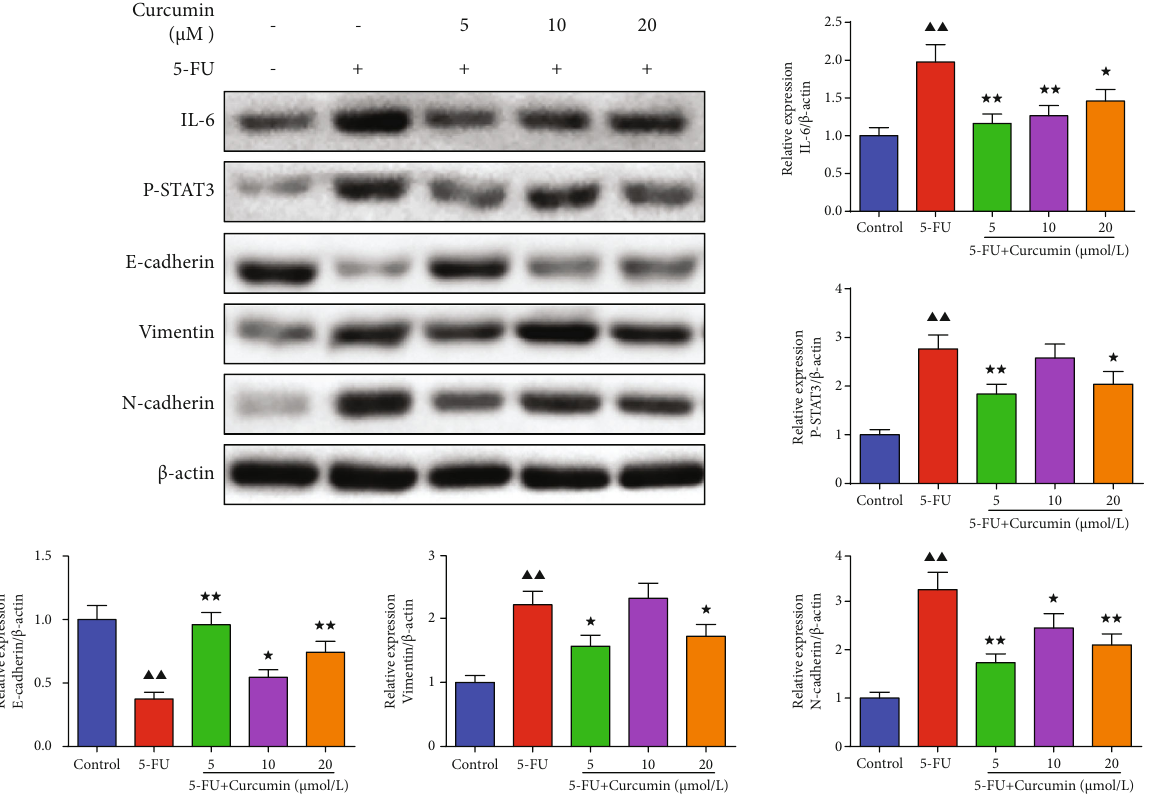
Figure 4: E ff ect of curcumin on the IL-6/STAT3 signaling in the 5-FU-stimulated IEC-6 cells. Western blotting assay was performed to detect the protein expression levels of E-cadherin, vimentin, N-cadherin, IL-6, and p-STAT3 in each group cells. Data were expressed as mean ± standard errormean (SEM), ▲▲ p value < 0.01 vs. control group; ∗ p value < 0.05 vs. 5-FU group; ∗∗ p value < 0.01 vs. 5-FU group. 5-FU: 5- fl